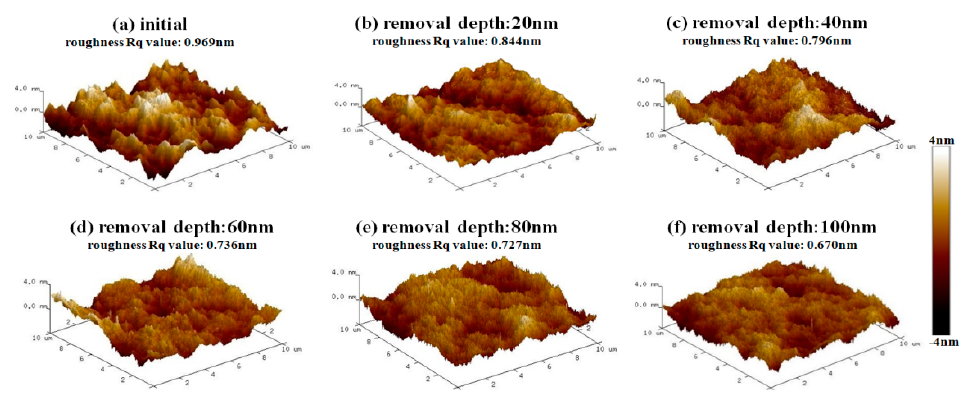
Figure 11. Morphology evolution of sample #2 after EJP processing.